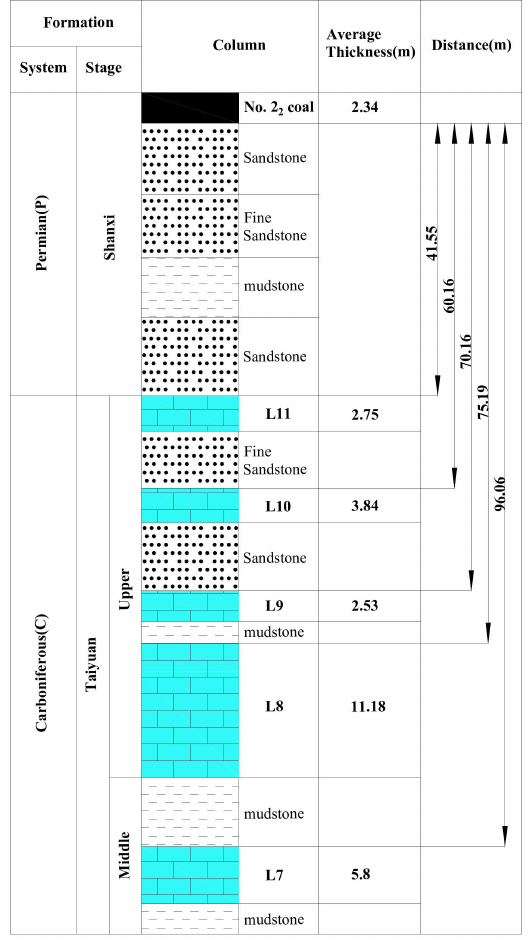
Figure 5. Histogram of the floor